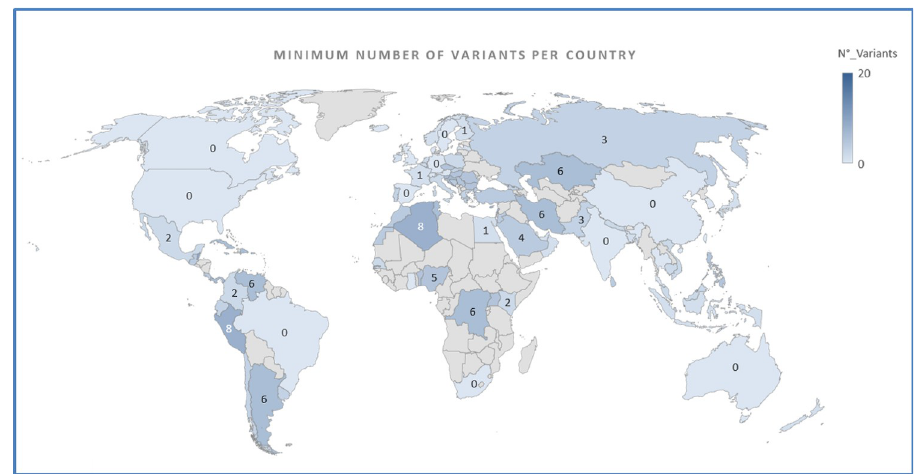
Fig 1. Geographical distribution of the minimum number of variants per